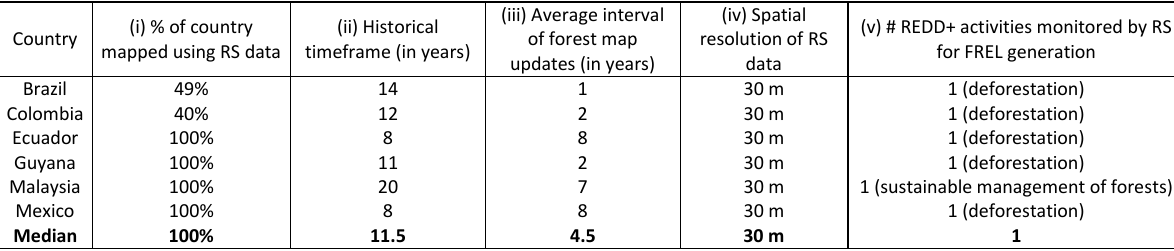
Table 1. Values for metrics (i)-(v) by country. Median value of each metric shown in bold